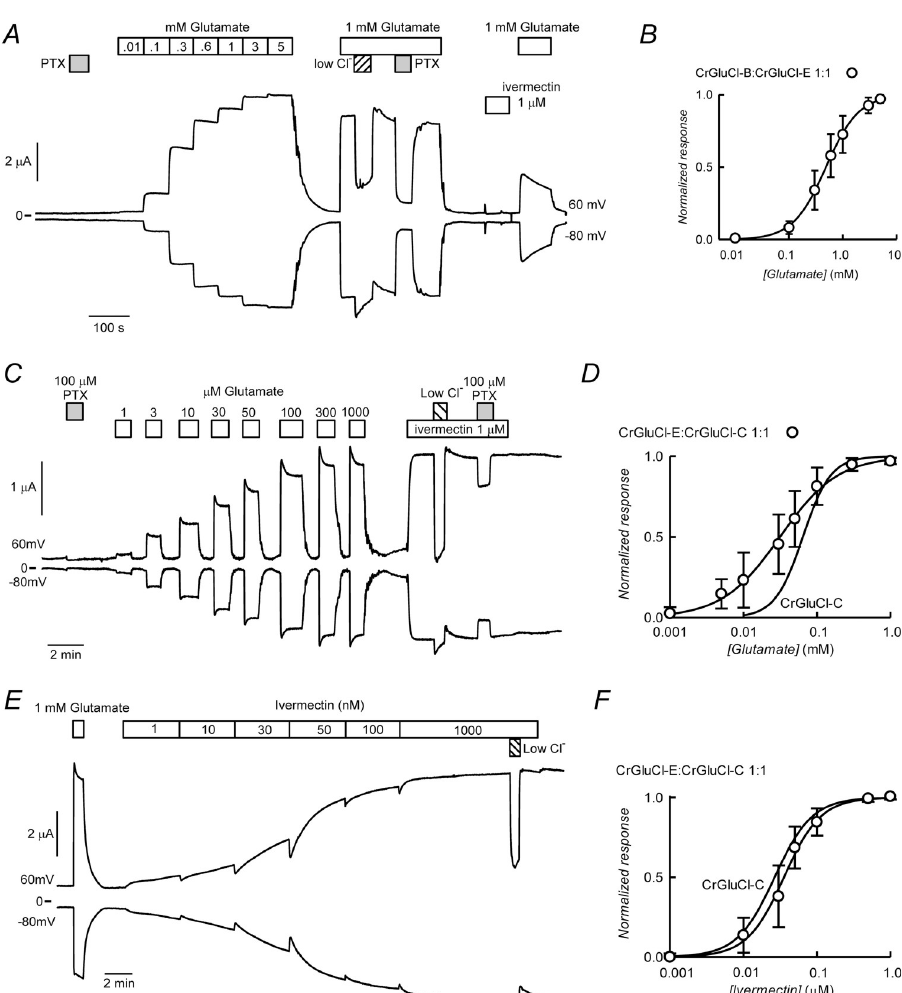
Fig 14. Functional properties of coexpressed subunits CrGluCl-E with CrGluCl-B and CrGluCl-E with CrGluCl-C in Xenopus oocytes. A. Currents elicited by increasing glutamate concentrations in an oocyte expressing subunits E and B after microinjection of 10 ng cRNA for each CrGluCl-E and CrGluCl-B. Recording taken at 60 and -80 mV. Also shown are the effect of partial chloride removal and addition of 100 μ M PTX. Ivermectin addition was done at 1 μ M. B. Dose-response relationship of the glutamate-sensitive currents of CrGluCl-E:CrGluCl-B mixed expression experiments. Data are normalized (mean ± SD, n = 6) to the maximal effect of glutamate. The line is a Hill equation fit. C. Currents elicited by increasing glutamate concentrations as indicated or 1 μ M ivermectin in an oocyte expressing subunits E and C 48–72 h after microinjection of 10ng cRNA for each CrGluCl-E and CrGluCl-C. Recordings taken at 60 and -80 mV. D. Dose-response relationship of the glutamate-sensitive currents of CrGluCl-E:CrGluCl-C mixed expression experiments. Data are normalized (mean ± SD, n = 6) to the maximal effect of glutamate. The line is a Hill equation fit. That for CrGluCl-C expressed on its own is also shown for comparison. E. Currents elicited by increasing ivermectin concentrations as indicated in an oocyte microinjected with 10ng cRNA for each CrGluCl-E and CrGluCl- C. F. Dose-response relationship of the ivermectin-sensitive currents of CrGluCl-E:CrGluCl-C 1:1 mixed expression experiments. Data are normalized (mean ± SD, n = 5) to the maximal response to ivermectin. The line is a Hill equation fit. That for CrGluCl-C expressed on its own is also shown for